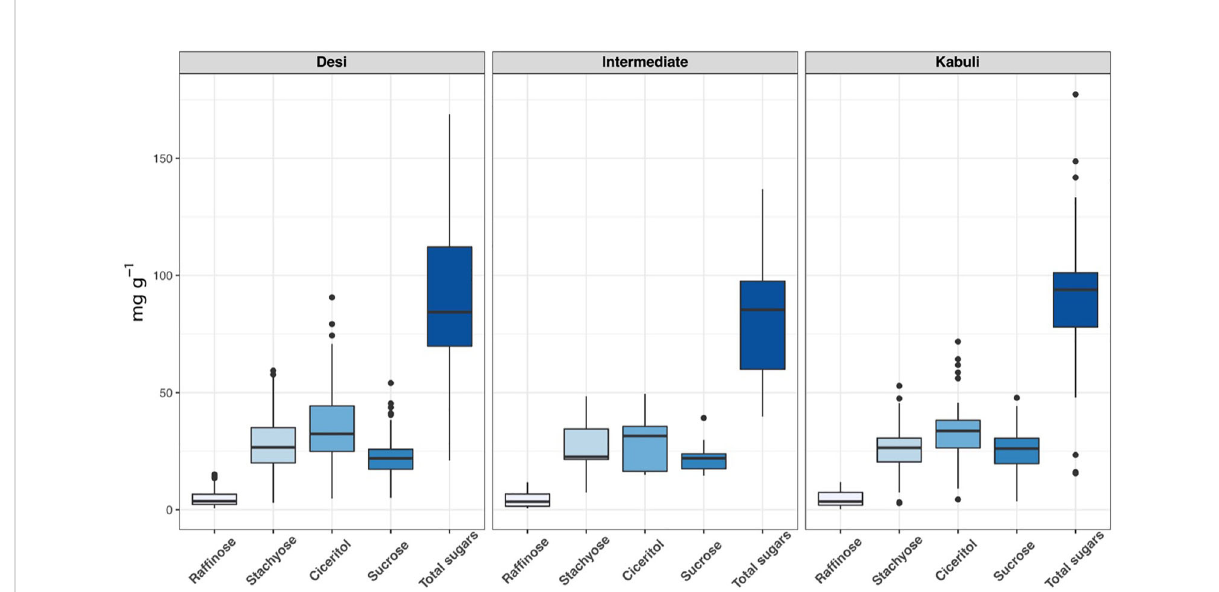
FIGURE 1 Seed oligisaccharides variations among desi, kabuli, and intermediate types in the ICRISAT chickpea mini-core